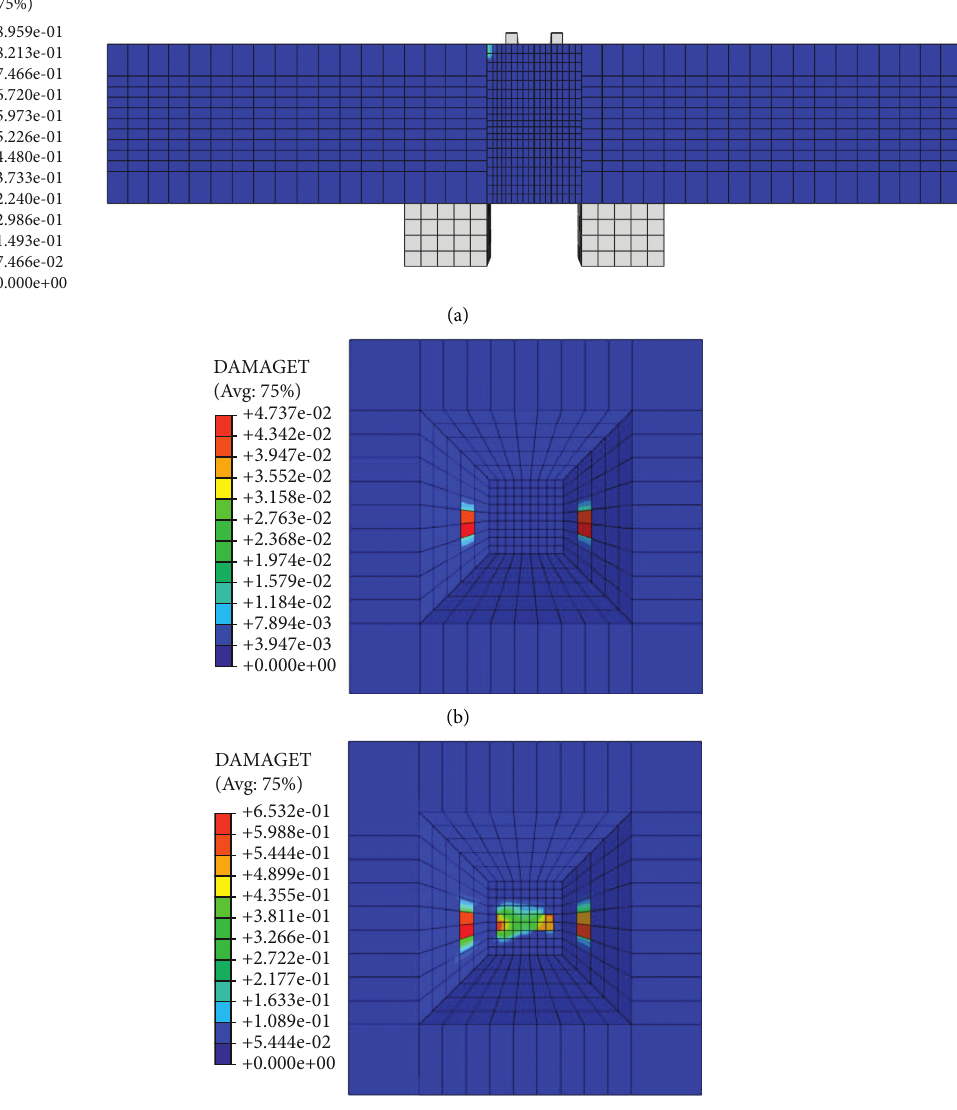
Figure 18: Crack patterns of Type 1. (a) Cracking patterns at failure. (b) Cracks at the first time. (c) Cracks at the failure of the shear